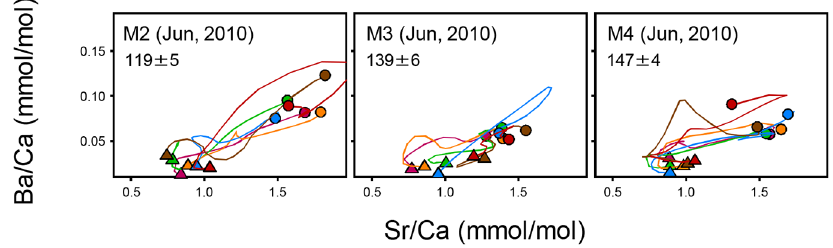
Figure 6. Sr-Ba elemental profiles along H.lobatus otolith transect. Triangle: otolith core. Circle: otolith surface. All samples were collected in June 2010 from 3 sites in the Mekong mainstream. Within a given site, different colors denote different individuals.